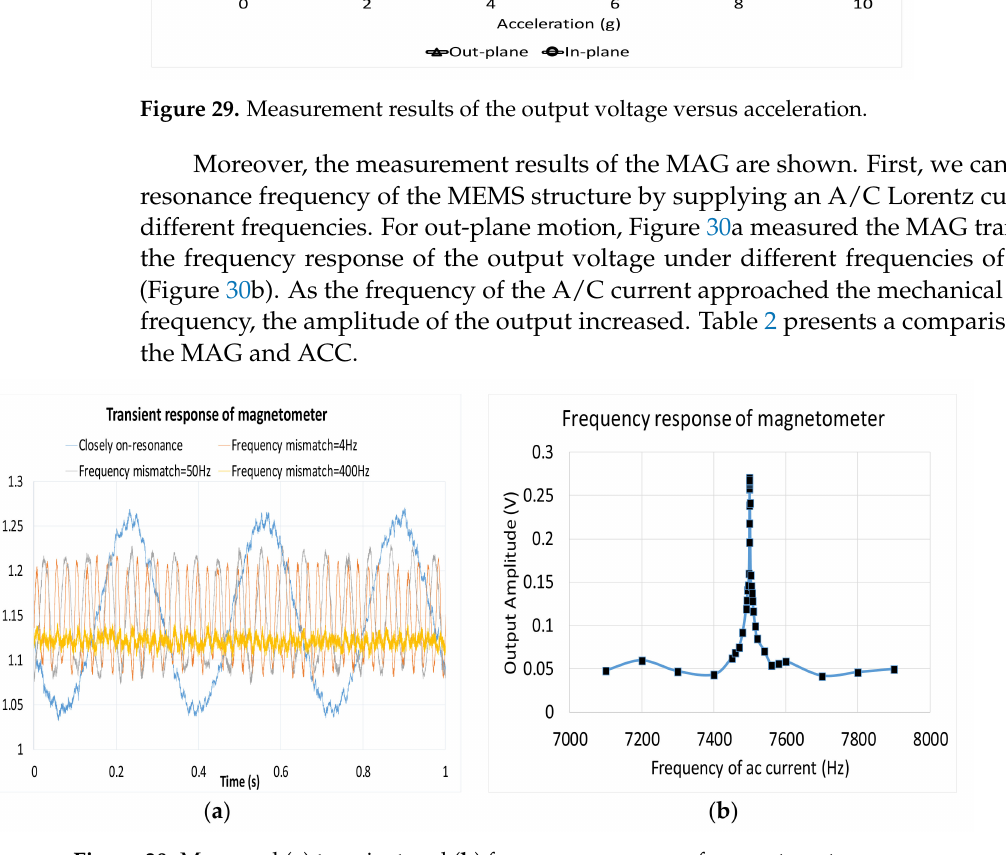
Figure 30. Measured ( a ) transient and ( b ) frequency response of magnetometer. Table 2. Summary of the specifications of the MEMS magnetometer and